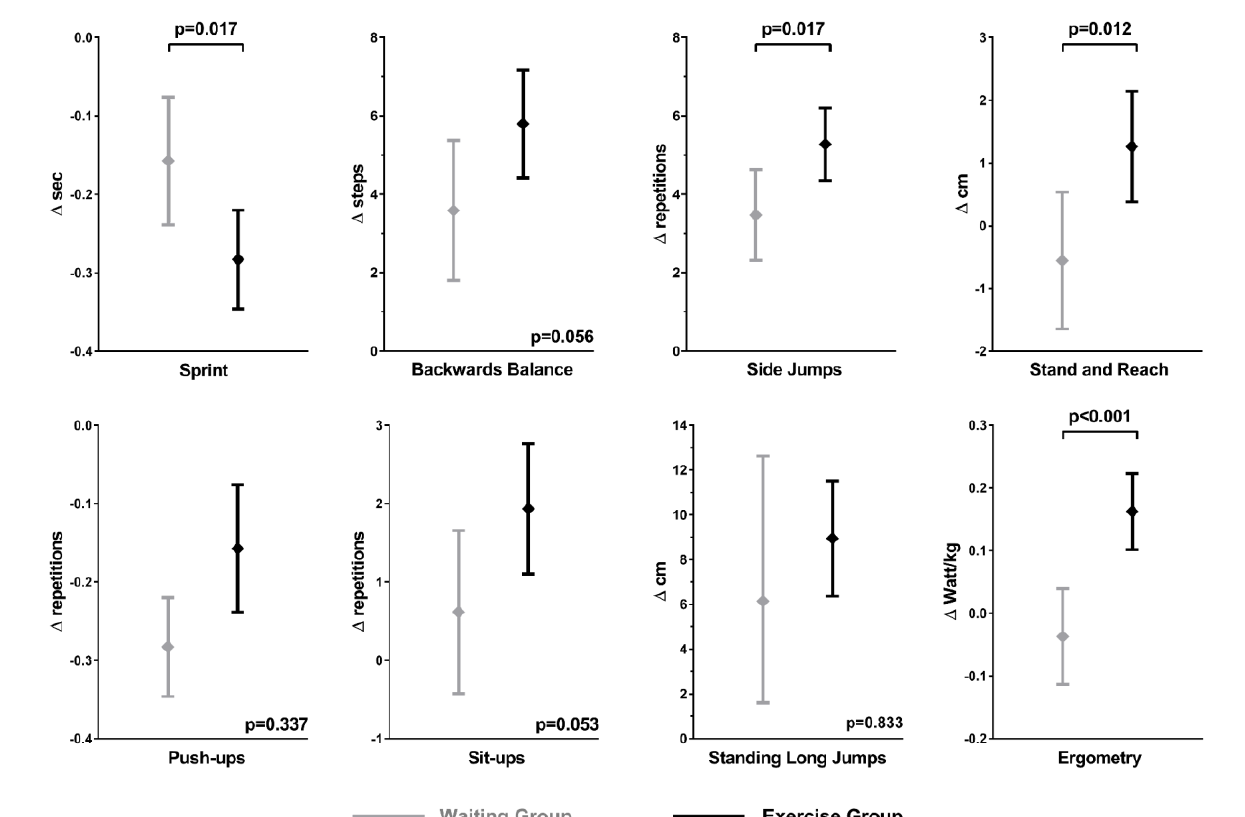
Figure 1. Comparison of the corrected means of the change in motor skills after one year between the waiting group (grey) and the exercise group (black), adjusted for age, sex, and BMI. The exercise group improved significantly more strongly than the waiting group in the sprint, side jumps, stand and reach, and ergometry test items and showed a tendency for stronger improvement in the backwards balance and sit-ups, while no significantly different change could be observed for the standing long jumps and push-ups.